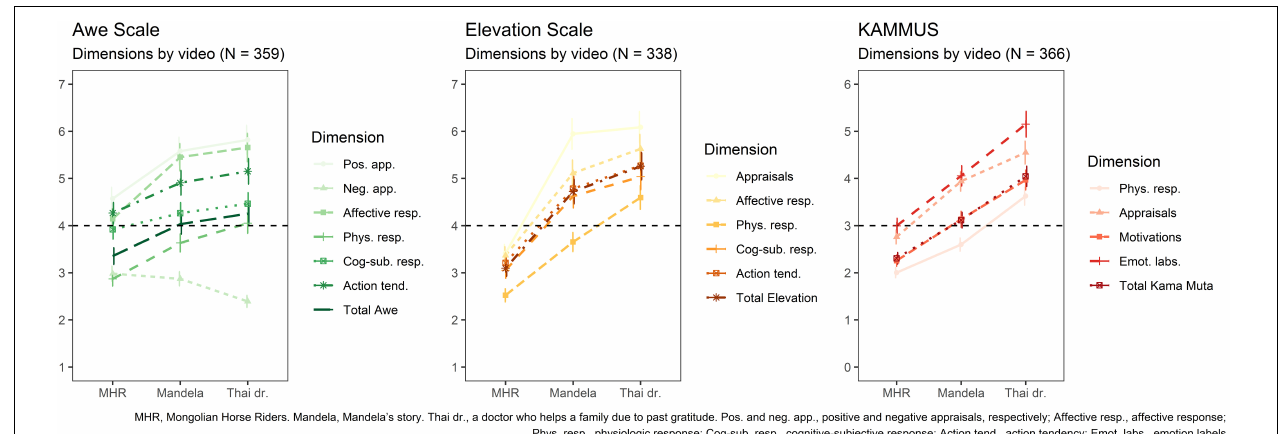
FIGURE 2 | Emotional reactions to each video. Means and 95% CI for Awe (Left) , Elevation (Center) , and Kama Muta (Right) dimensions’ reactions to each video. The black dotted line from the y-axis represents the center point for each scale.